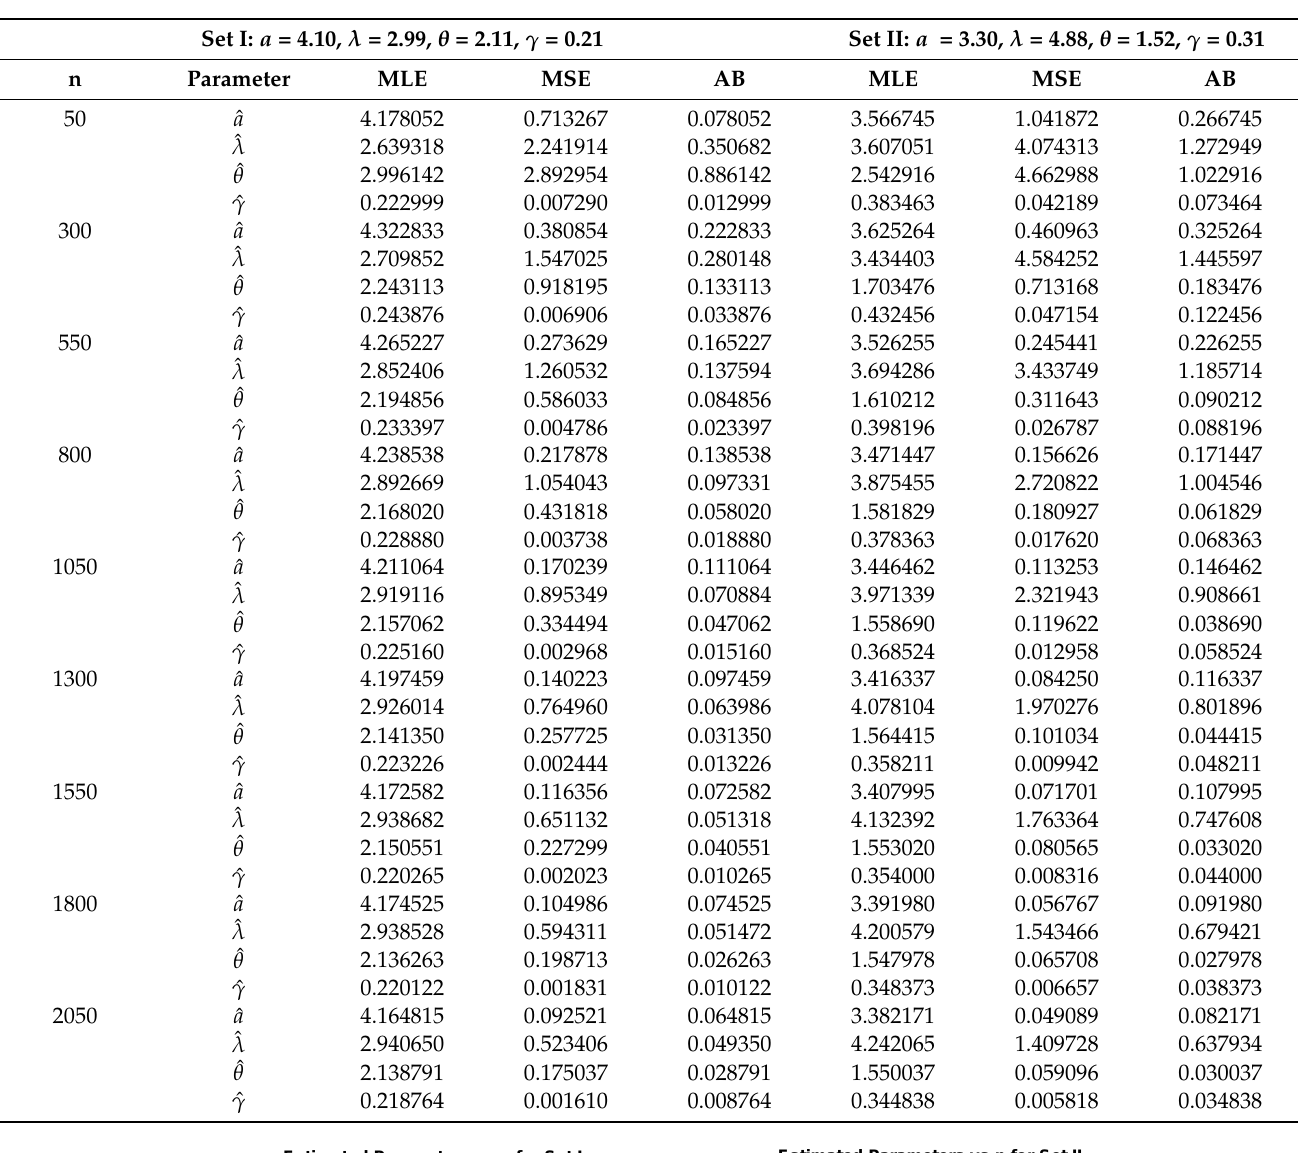
Table 1. Simulation results for NGE3ED.